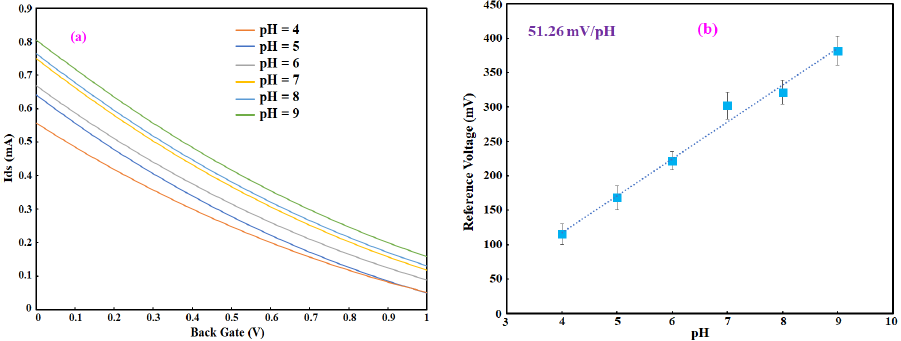
Figure 9. Drain-source voltage graphs for different pH values for OG-JFET. ( a ) Ids-Vgs curve for different pH solutions from pH = 4 to pH = 9. ( b ) The voltage sensitivity relative to the back gate reference voltage.